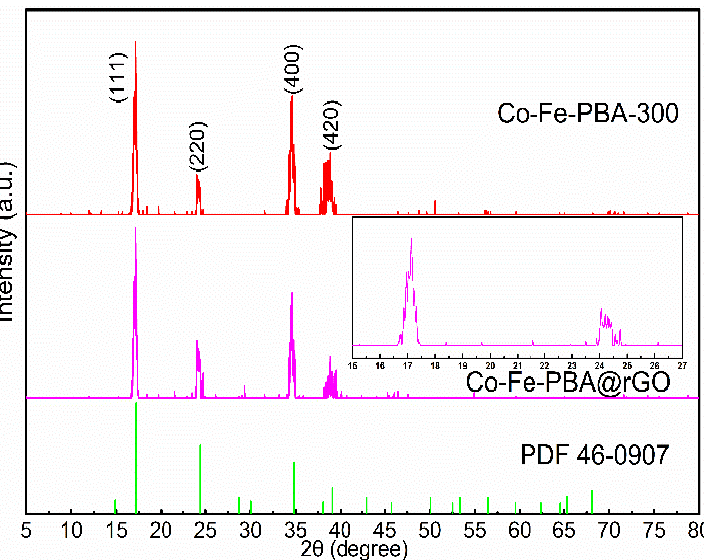
Figure 1. XRD patterns of Co-Fe-PBA-300 and Co-Fe-PBA@rGO. Figure 2 and Figure S1 present field-emission scanning electron microscopy